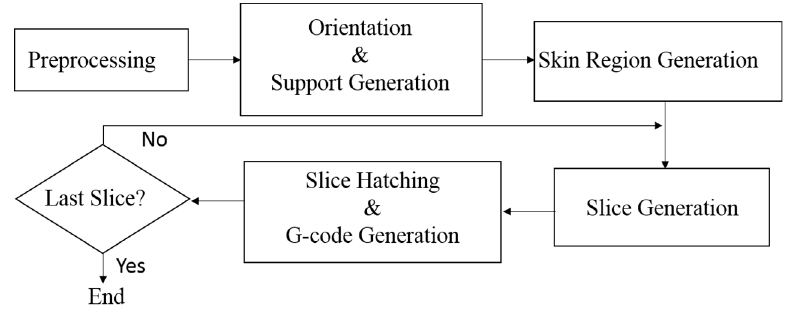
Figure 1. Pipeline of the proposed slicer.